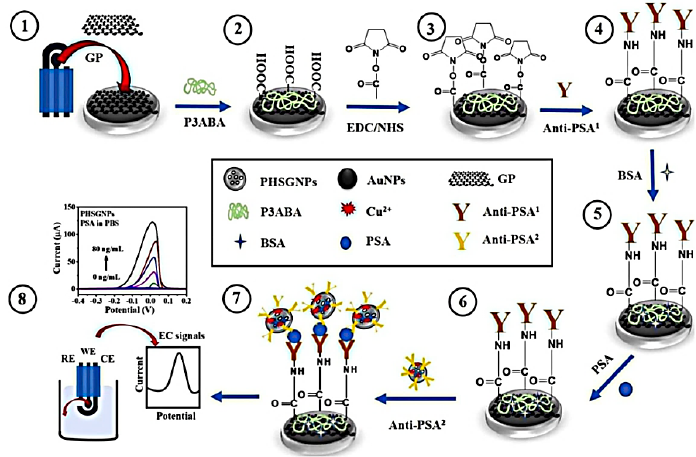
Figure 10. Schematic illustration of biosensing platform (core-shell hollowed-porous-gold-silver nanoparticles (PHSGNPs) and graphene-poly (3-aminobenzoic acid) (GP-P3ABA)) for PSA detection. Reproduced from [175] with permission from Elsevier,